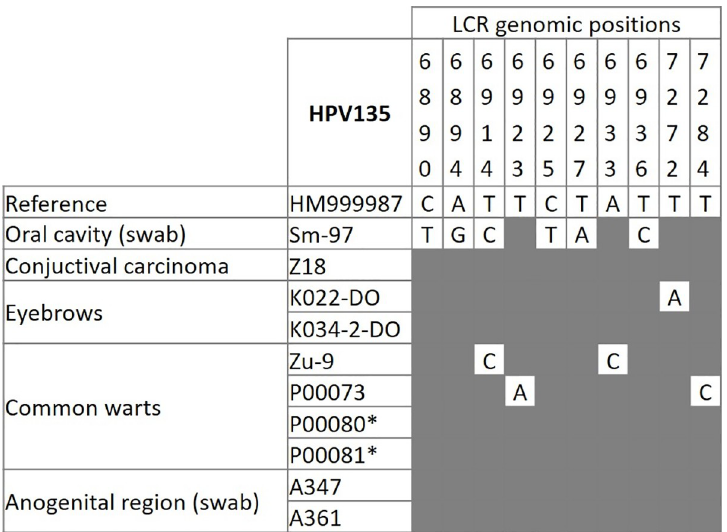
Fig 2. Long control region viral variants of human papillomavirus type 135 in two samples obtained from an immunocompromised patient (P00080 and P00081, marked with a star) and in eight independent samples obtained from immunocompetent individuals (GenBank acc. nos. MW574236 –MW574245). The top of the frequency table shows the nucleotide sites of substitutions in HPV135 isolates investigated according to the HPV135 reference genome. Nucleotide sites where no substitutions or deletions were observed are marked gray.